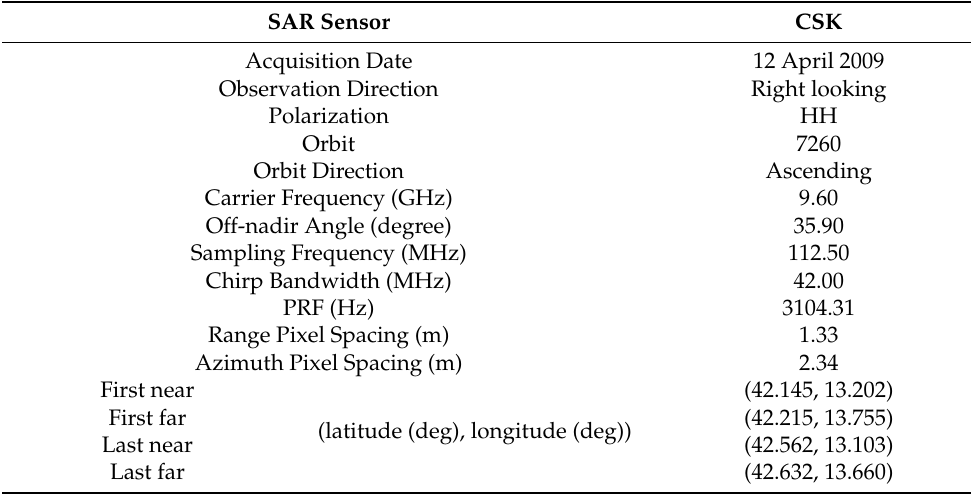
Table 1. SAR Dataset